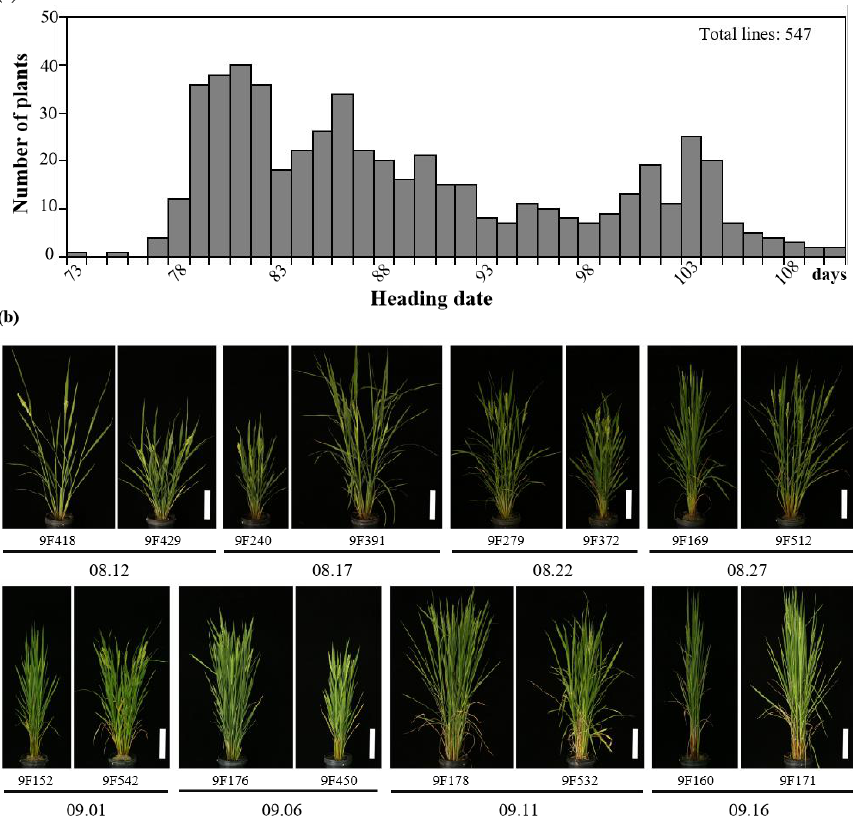
Figure 4. Multiple-heading-date mtl haploid inducers. ( a ) Heading date frequency distribution in the 547 RILs derived from transgene-free haploid inducer lines #1, #2, #3 and #4. ( b ) Plant morphology and heading date of 16 mtl haploid inducers. Seeds were sown on 30 May, and plants were grown in Hangzhou, China. Bar = 20 cm.